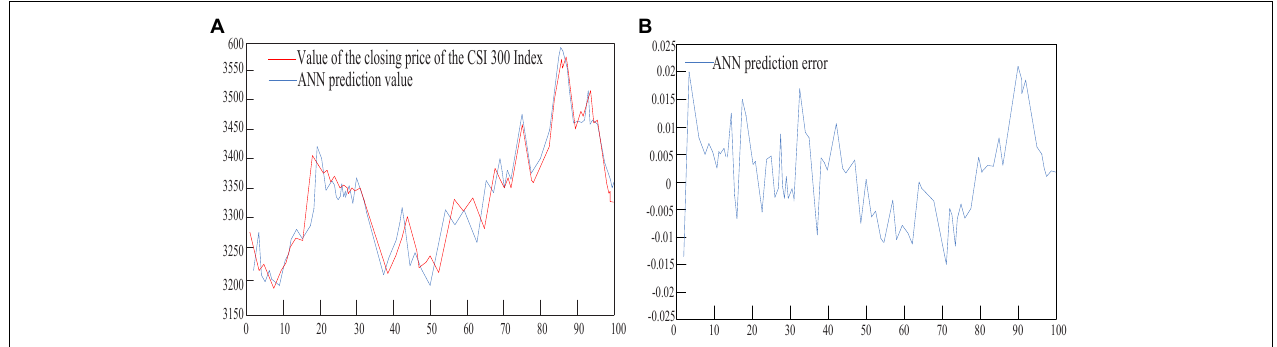
FIGURE 9 | Artificial neural network model test. (A) Is a simulation diagram of artificial neural network model test results. (B) Shows the error of the artificial neural network model test